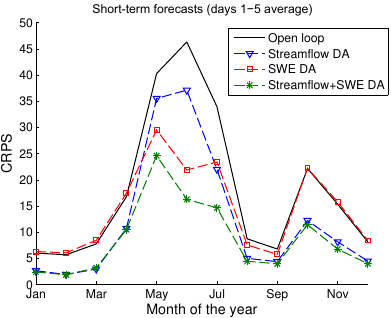
Figure 12. Continuous rank probability score for short-term fore- casts (average of forecast horizons 1 through 5 days) of various data assimilation scenarios as a function of the month of the year.